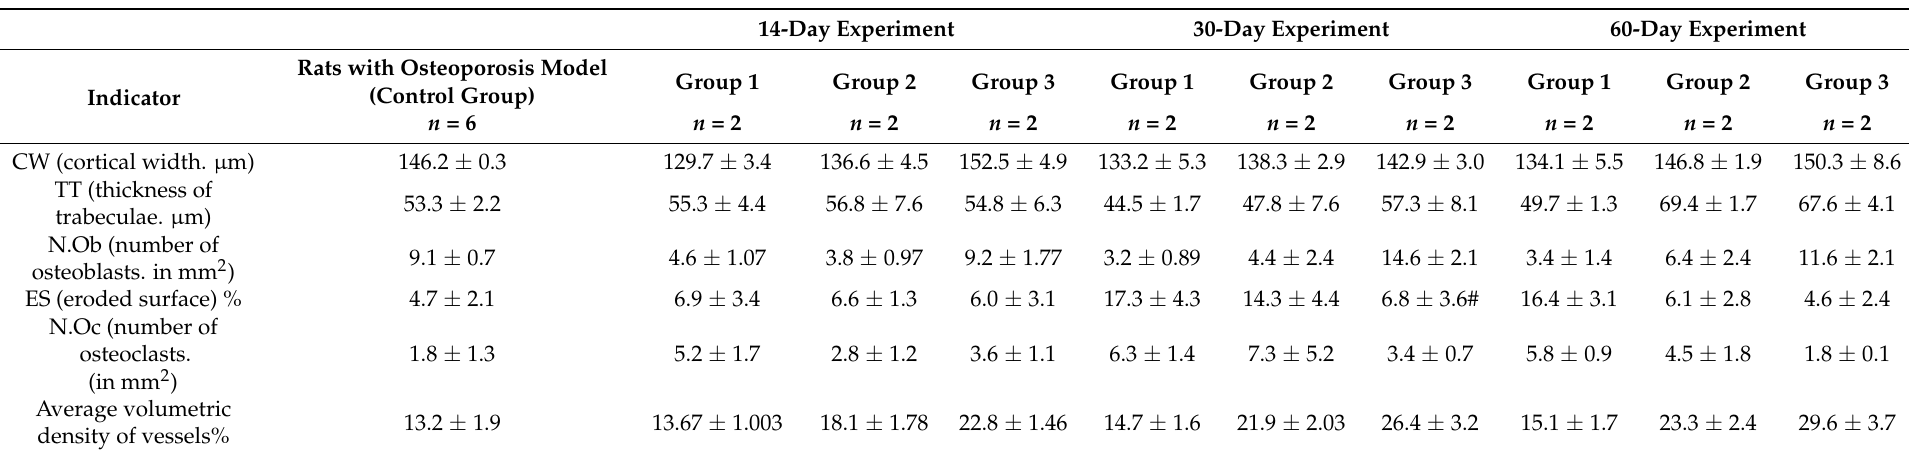
Table 1. Indicators of morphometry of the femur of rats with a fracture in the shaft of the